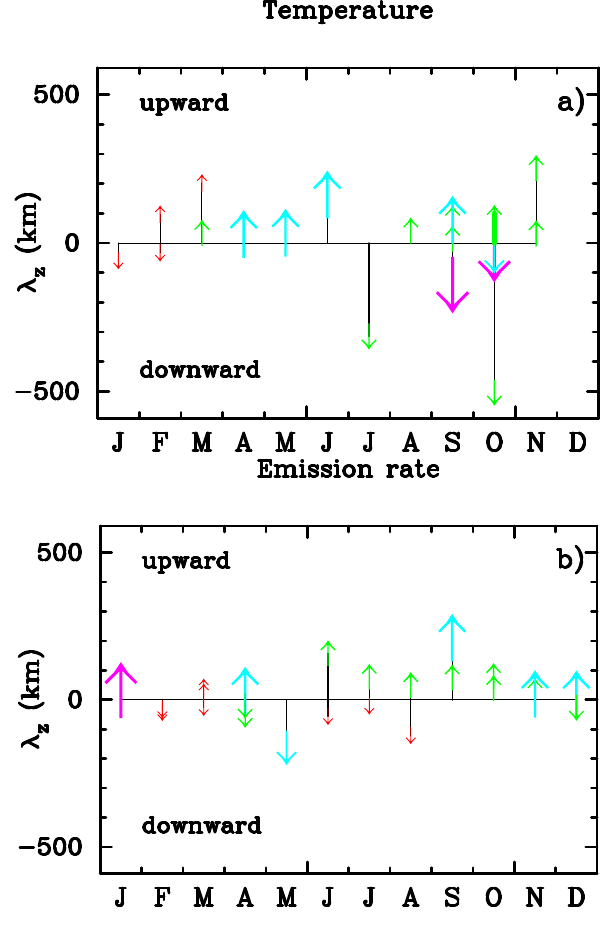
Fig. 7. Vertical wavelength as function of the month. Red and small arrow: 2-day; Green and normal arrow: 5-day; Blue and big arrow: 10-day; Pink and huge arrow: 16-day. (a) Calculated from temper- ature. (b) Calculated from emission